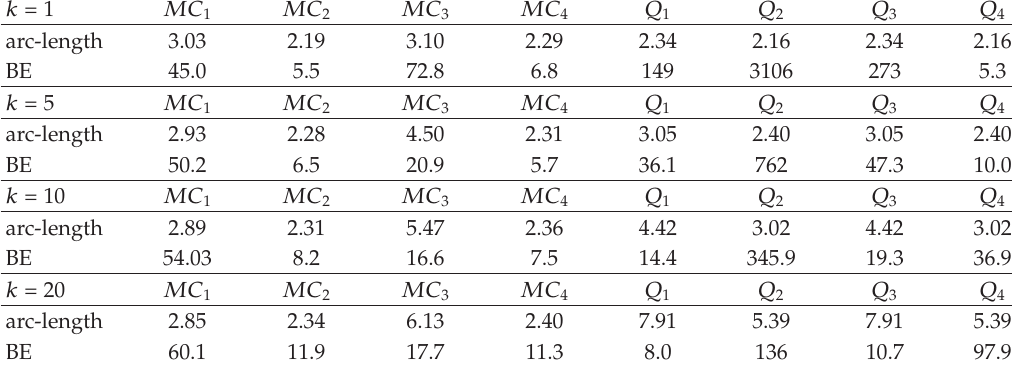
Table 1: Comparison of arc-length and bending energy for the interpolants of Figure